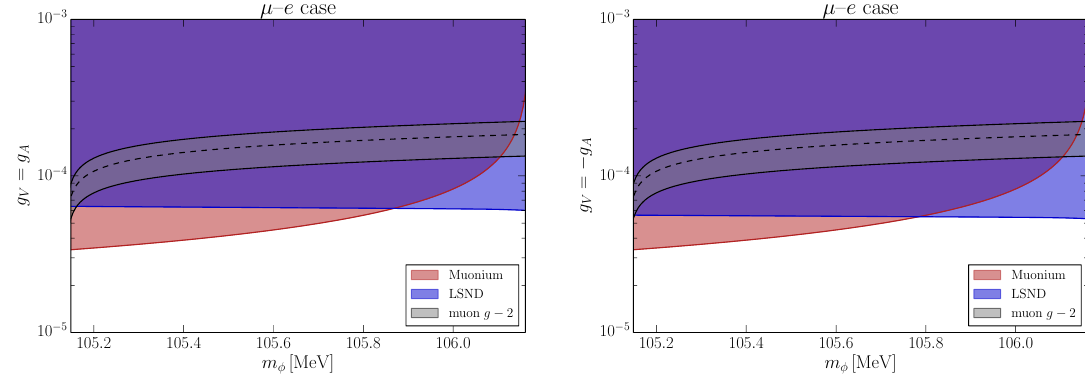
Figure 3 . The constraints on the couplings in the µ – e case. The region excluded by the muonium invisible decay and the LSND is covered in red and blue, respectively. The black dashed line corresponds to the central value of the muon g − 2 anomaly, and the gray region indicates the 1 σ band. The left panel is with g V = g A while the right panel is with g V = − g A . Note that only the LSND constraint is (mildly) affected by the relative sign between g V and g A . One can see that the whole parameter region favored by the muon g − 2 is excluded.